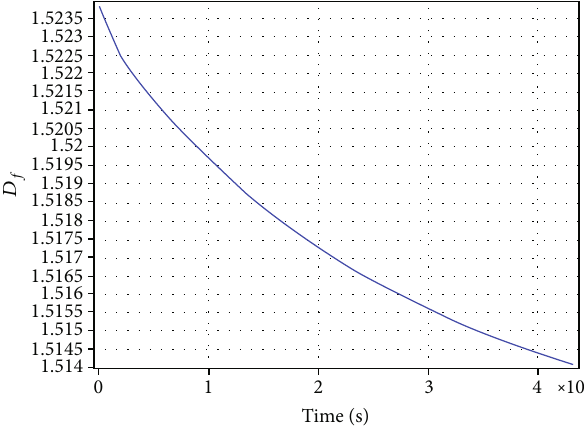
Figure 10: Evolution of the fractal dimension of fracture length at the location (0.025, 0.05) by the fractal model.